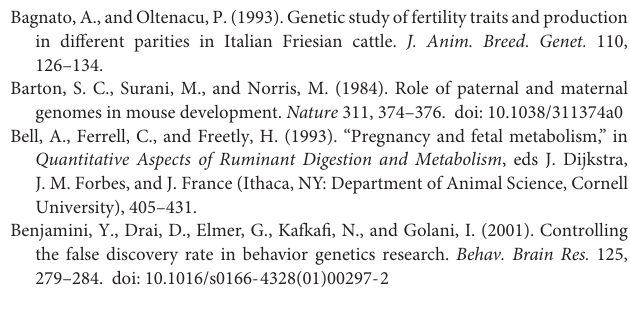
Supplementary Figure 1 | The linkage disequilibrium decay of the population. Supplementary Figure 2 | The Gene Ontology- and Kyoto Encyclopedia of Genes and Genomes-based network analysis of candidate genes of genetic effect of service sire on success traits using ClueGO application in Cytoscape. Supplementary Figure 3 | The Gene Ontology- and Kyoto Encyclopedia of Genes and Genomes-based network analysis of candidate genes of genetic effect of service sire on calving traits using ClueGO application in Cytoscape. Supplementary Figure 4 | The Gene Ontology- and Kyoto Encyclopedia of Genes and Genomes-based network analysis of candidate genes of genetic effects of the dam on success traits using ClueGO application in Cytoscape. Supplementary Figure 5 | The Gene Ontology- and Kyoto Encyclopedia of Genes and Genomes-based network analysis of candidate genes of genetic effects of the dam on calving traits using ClueGO application in